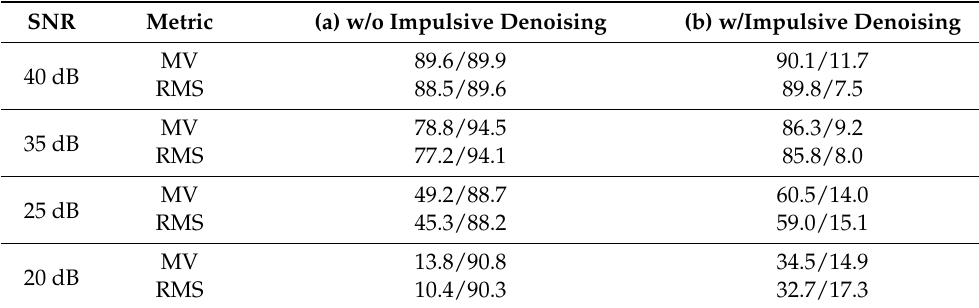
Table 6. Performance comparison (DR/FER (%)) between (a) random PQD detection without impulsive denoising and (b) random PQD detection with impulsive denoising, where an 80% pu sag signal over IMPN with SNR = 20, 25, 35, or 40 dB; µ = 400; and ψ = 0.02% is